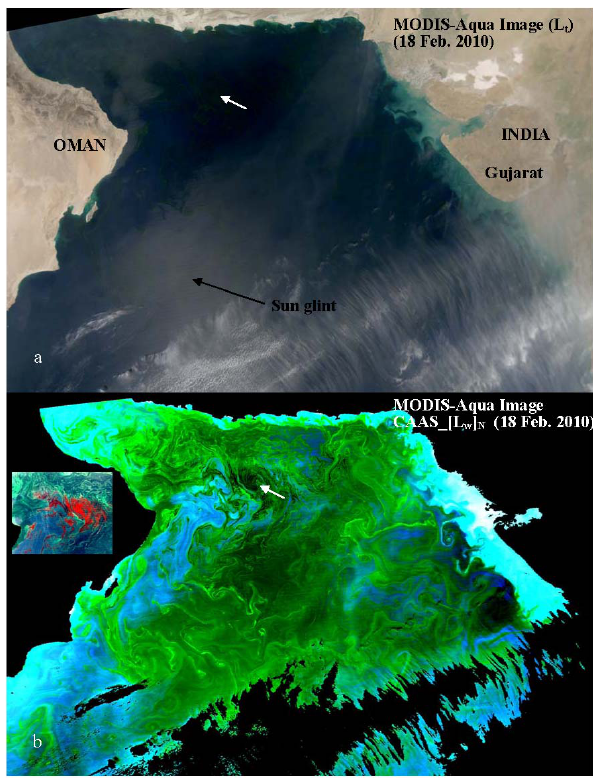
Fig. 2. MODIS-Aqua true colour composite imagery (18 Febru- ary 2010) for the Arabian Sea generated from the total radiances at 443, 551 and 488nm (B253) (a) and the corresponding water- * Replace the previous one with this figure (see a white arrow inserted on the top panel). leaving radiance imagery from the CAAS algorithm (b) . Subset im- age generated from the [ L w ] N at 748, 678 and 667nm (Band 876) are displayed on the left side of the bottom panel confirming highly concentrated patches of algal blooms in the northern central Ara- bian